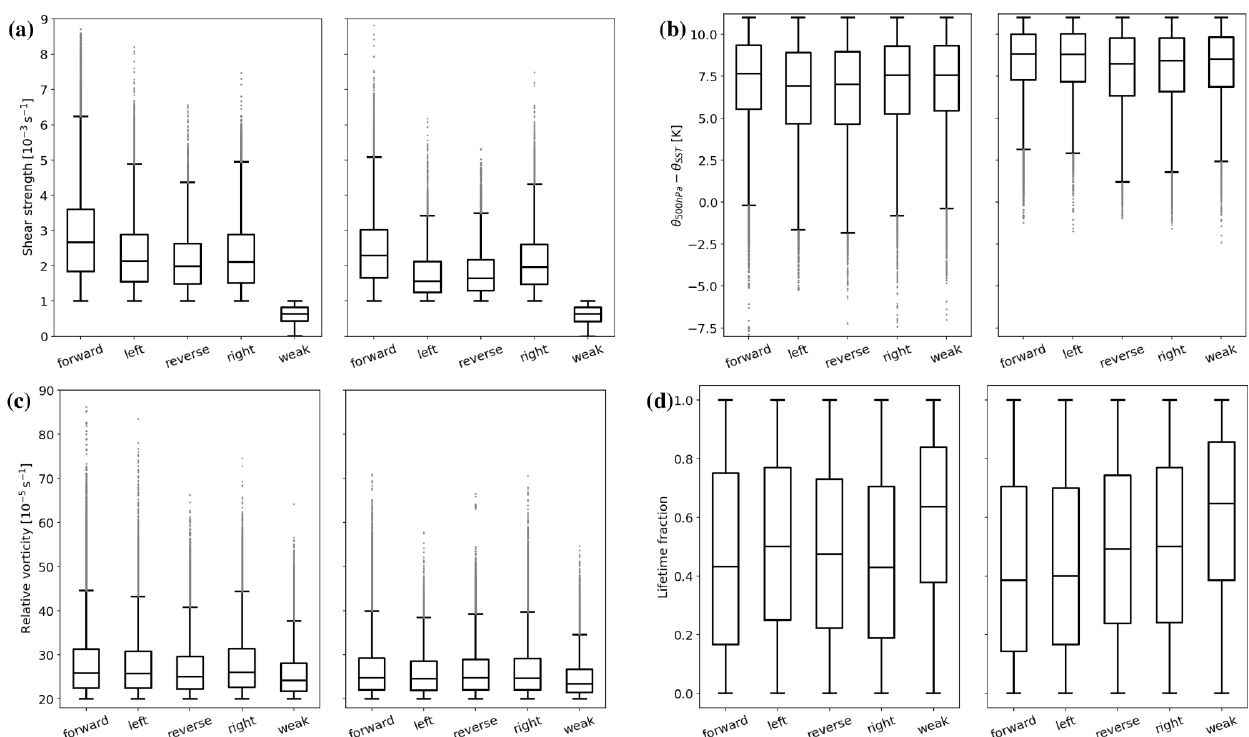
Figure 10. Parameter distribution in (a) the vertical-wind-shear strength, (b) the static stability, (c) the relative vorticity, and (d) the lifetime fraction for the different shear categories of (a, c) the Northern Hemisphere and (b, d) the Southern Hemisphere. The parameters are computed for all polar-low time steps within the shear category, since a given polar low often changes shear category during its life. Note that left shear in the Northern Hemisphere and right shear in the Southern Hemisphere are attributed to PLs propagating towards warmer